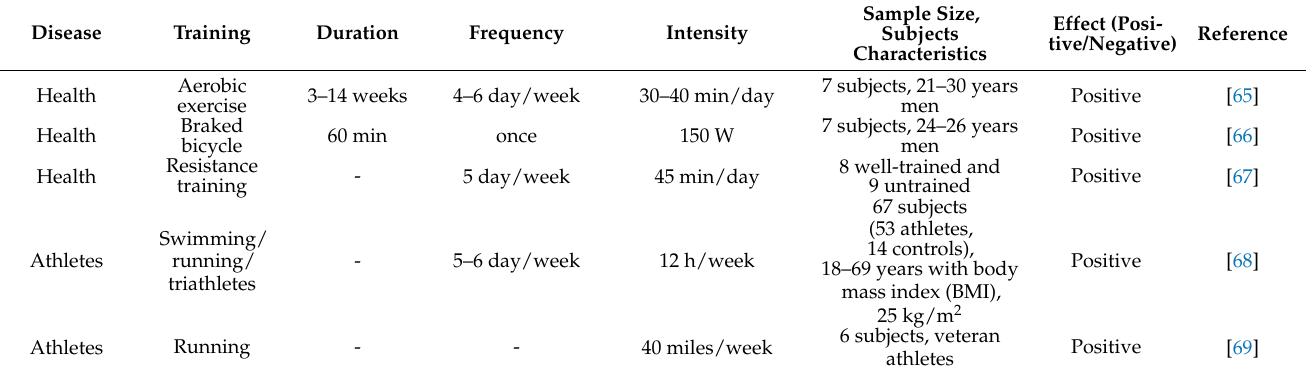
Table 4. Exercise intervention characteristics of included human model